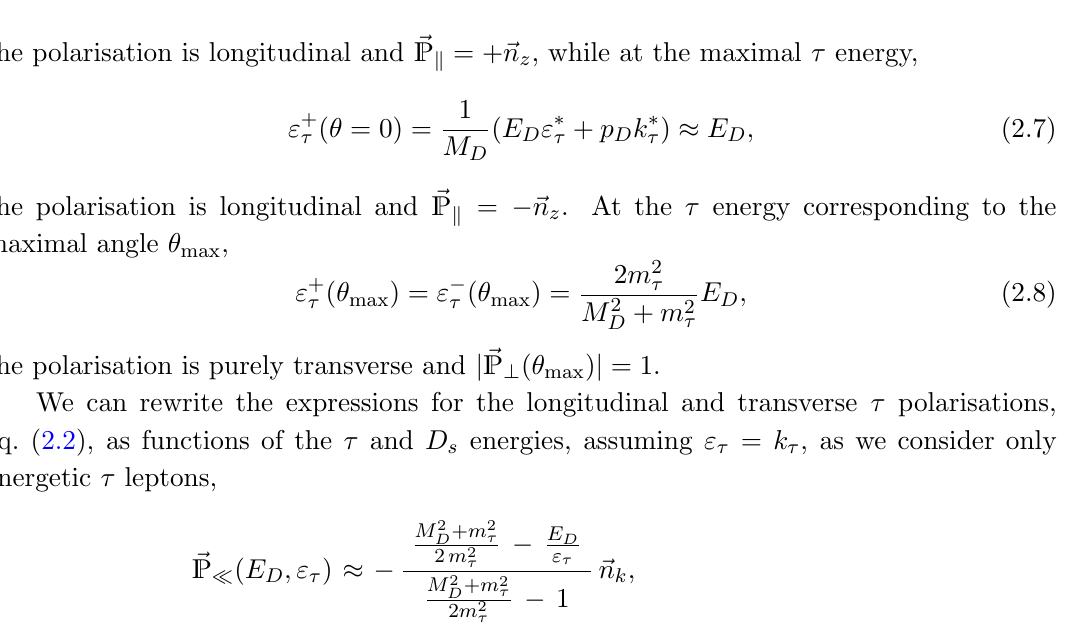
(cid:28) + (cid:23) (cid:28) in the (left) D s rest frame and (right) Lab frame. The axis Oz is Figure 1 . The decay D + s ! chosen along the direction of D s momentum. Rotational symmetry around the Oz axis is implied. The ellipsoid is actually very elongated along the axis Oz because (cid:13) D 1. The blue arrows show (cid:29) the (cid:28) momentum ~k (cid:28) , and the thick red arrows the (cid:28) polarisation vector, ~ P . Several cases of (cid:28) polarisation in the Lab frame are shown: (1, 2) (cid:18) = 0, (3) (cid:18) = (cid:18) max and (4, 5) an arbitrary (cid:18)